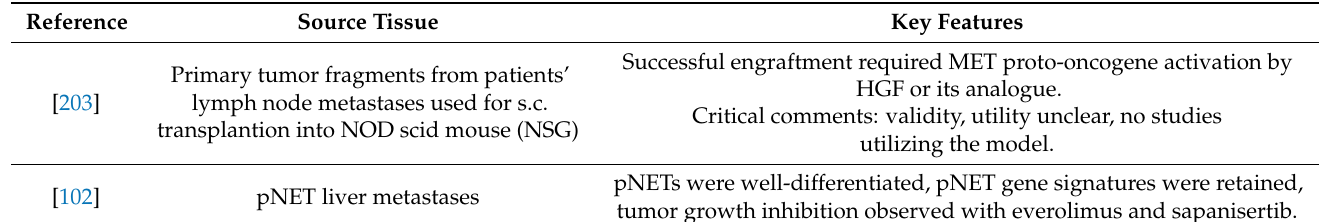
Table 13. Patient-derived xenografts